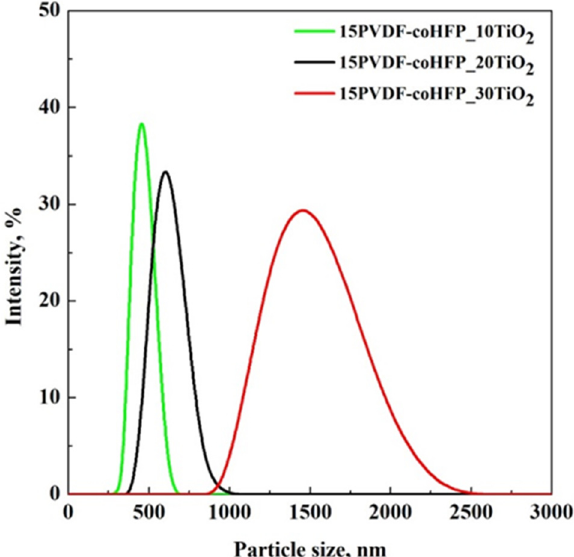
Figure 8. DLS results of the starting PVDF-coHFP solutions loaded with TiO 2 . It is possible to observe that the mean size of TiO 2 clusters in the solutions increased from 460 nm to 615 nm for a TiO 2 wt% equal to 10% and 20%, respectively. However, DLS results overestimated the size of these TiO 2 particle clusters in the 15PVDF-coHFP solu- tions since they were not found in the produced membranes, as evidenced by SEM re- sults (Figure 2a,b). It is worth noting that when TiO 2 content in the polymeric solution nm, in agreement with SEM images observation (Figure 2c). Since for a photocatalyst content up to 20 wt%, the TiO 2 cluster size was smaller than that one obtained at 30 wt% TiO 2 loading, it is possible to argue that the effect of photocatalyst cluster size strongly affected both adsorption properties and photocatalytic activity of the membranes (see Figure 7a,b). 3.4. Reusability Test of 15PVDF-coHFP_20TiO 2 Membrane A reusability test was performed after drying at room temperature of the 15PVDF-coHFP_20TiO 2 membrane recovered from the treated aqueous solution at the end of the adsorption/photocatalytic process and reused without regeneration step among the different cycles. Figure 9 reports five cycles of SB adsorption in dark condi- tions on the same 15PVDF-coHFP_20TiO 2 membrane.